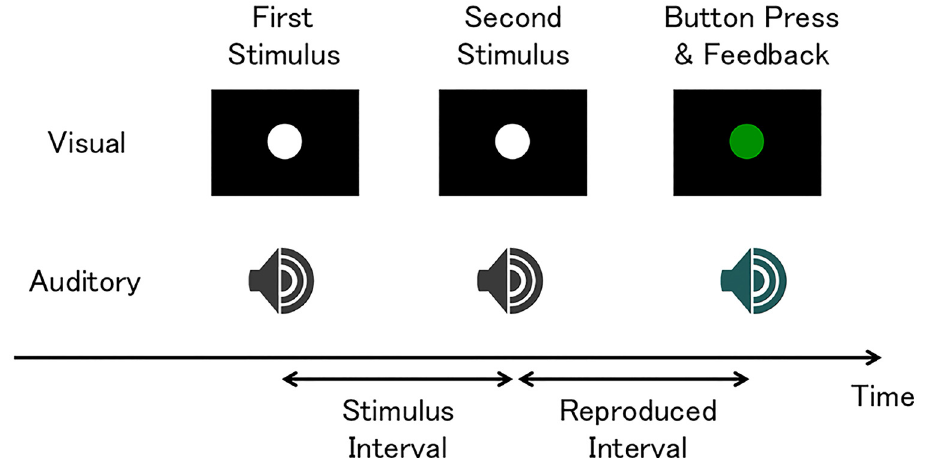
Fig 1. Schematic of the experimental procedure. Two brief flashes or tones were sequentially presented, and participants made button presses to reproduce the interval. Correct or incorrect feedback was presented immediately after participants ’